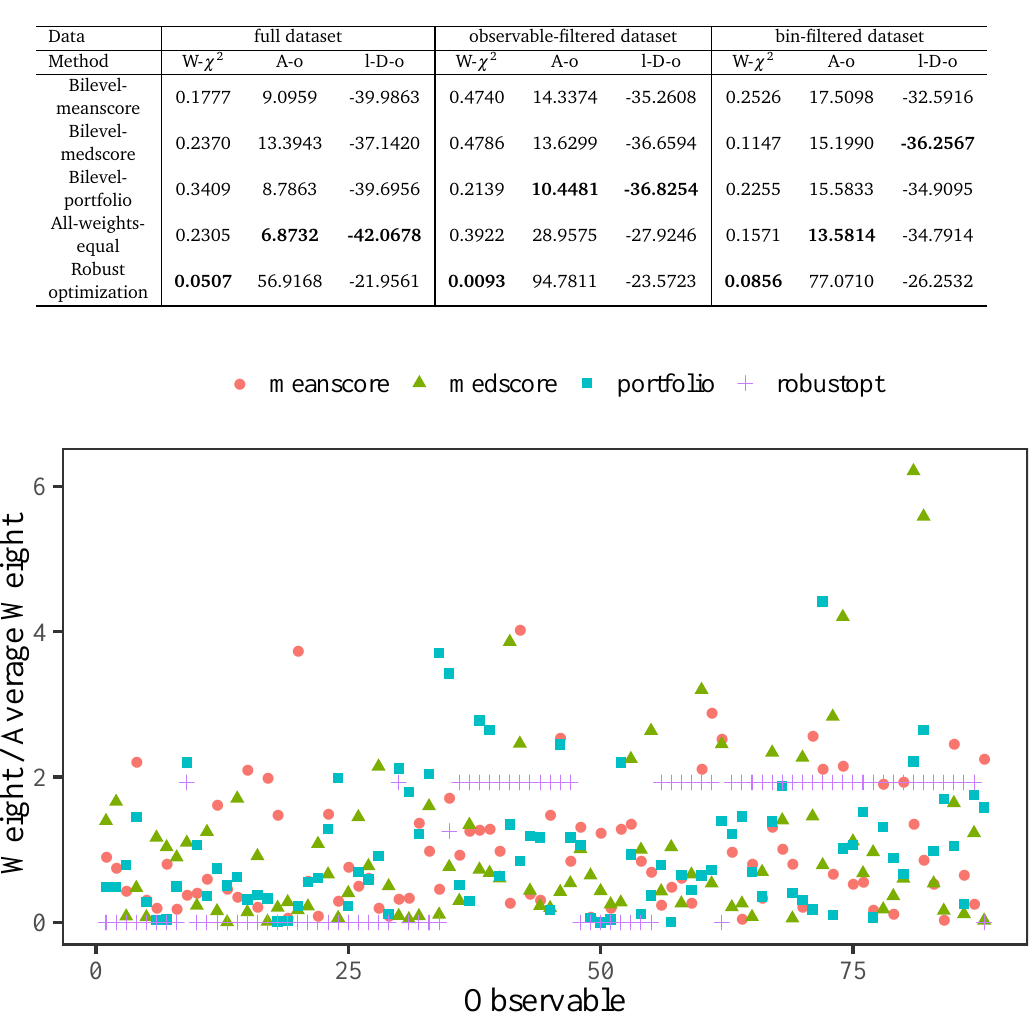
Table 31: Results for the comparison metrics for the full, observable-filtered and bin- filtered S HERPA dataset using the cubic polynomial approximation, calculated on the reduced dataset. The best results are in bold. In each dataset, W- χ 2 refers to the Weighted χ 2 metric, A-o refers to the A-opt metric, and l-D-o refers to the log D-opt metric. Note that we do not have an expert solution for this dataset.